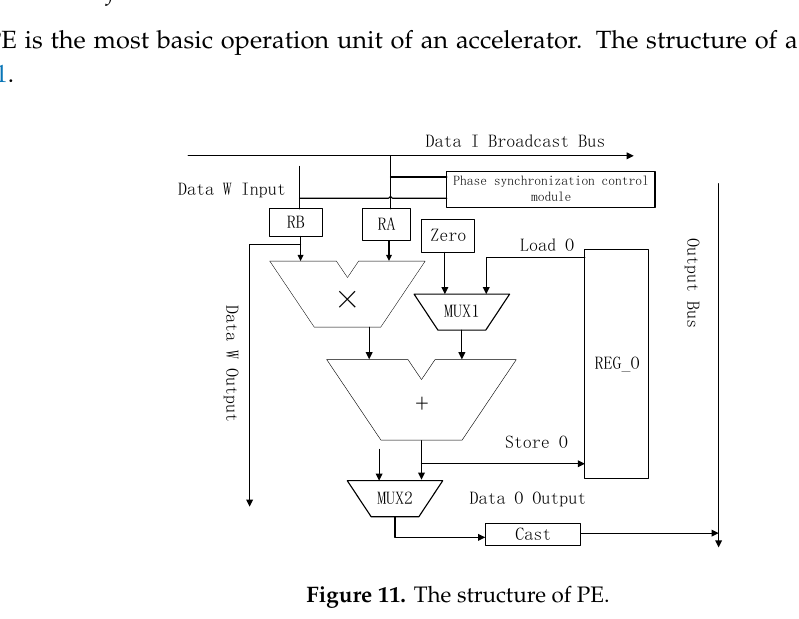
Figure 11. The structure of PE.